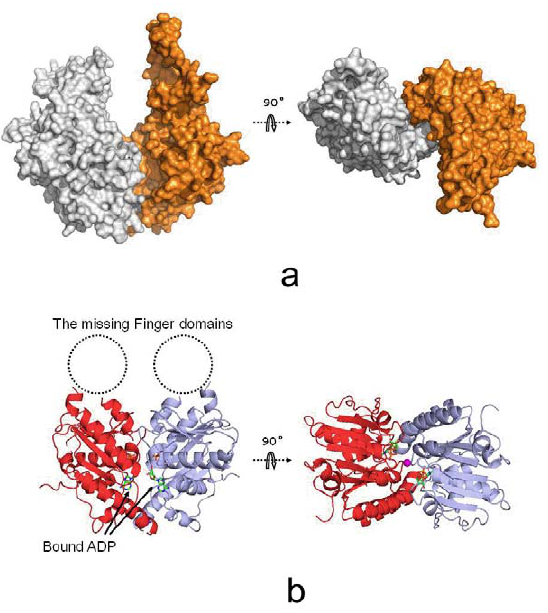
Figure 5. The structural comparison between S.cerevisia and D. hansenii Get3 dimer. a) The molecular surface drawing of the Get3 dimer by Pymol. The monomer A is in silver and the monomer B is in gold. The orientation of the Get3 dimer in the left panel is similar as that in Fig. 1. b) The Ribbons drawing for D. hansenii Get3 homo-dimer. One monomer is in red and the other is in blue. The missing finger domains are indicated in dotted circle. The Zinc ion is shown in a pink sphere. The bound ADP molecules are labeled and shown in rod model.